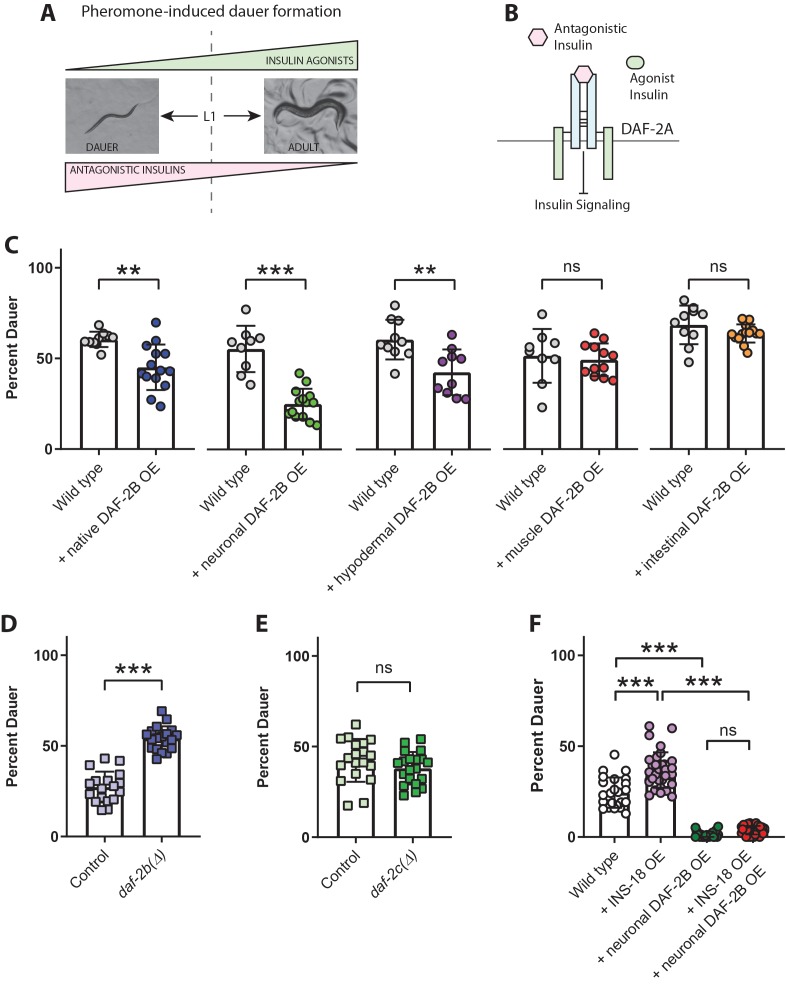
DAF-2B attenuates the activity of antagonistic insulin peptides.(A) In the presence of the dauer-inducing pheromone extracts, the decision in the first larval stage (L1) to proceed with reproductive growth or enter the dauer stage is dependent on the balance between antagonistic and agonistic insulin peptides. (B) Increased activity of antagonistic insulin peptides inhibits insulin signaling to promote dauer entry. (C) DAF-2B overexpression (OE) from the native daf-2 promoter, in the nervous system, or in the hypodermis suppresses pheromone-induced dauer formation in wild type animals. There was no effect of DAF-2B expressed in the intestine or in the body wall muscle. Data are pooled from 2 (hypodermal promoter) or 3 (all other promoters) transgenic lines with at least four biological replicates per transgene. Students t-test ns – not significant, **p<0.01, ***p<0.001. Similar effects were observed in an additional trial for muscle, intestine and neuronal promoters and 1/2 additional trials for the native promoter. Raw data can be found in Figure 7—source data 1. (D) Genetic deletion of daf-2b enhances dauer formation in the presence of pheromone extracts. Data are pooled from two independent trials with three biological replicates from each of two control and two daf-2b(Δ) strains per trial. Students t-test ***p<0.001. Raw data can be found in Figure 7—source data 2. (E) Genetic deletion of daf-2c has no effect on dauer formation in the presence of pheromone extracts. Student t-test ns – not significant. Raw data can be found in Figure 7—source data 3. (F) Overexpression of the INS-18 antagonist insulin peptide from the native ins-18 promoter enhances pheromone-induced dauer formation in wild type animals, while overexpression of DAF-2B from an integrated neuronal rab-3 promoter suppresses dauer formation. Combined overexpression of INS-18 and DAF-2B also suppresses dauer formation compared with INS-18 overexpression alone. Data are pooled from two independent trials with 12 biological replicates for wild type, 11 or 12 biological replicates for the integrated neuronal DAF-2B OE line and 2 or three biological replicates from each of 6 INS-18 OE extrachromosomal array lines. Post-hoc pairwise comparisons following one-way ANOVA ***p<0.0001. Raw data can be found in Figure 7—source data 4. Error bars represent mean ± sd, and data are shown as independent replicates from multiple transgenic lines.Figure 7—source data 1.DAF-2B overexpression suppresses pheromone-induced dauer formation in wild type.Figure 7—source data 2.daf-2bdeletion enhances pheromone-induced dauer formation in wild type.Figure 7—source data 3.daf-2cdeletion has no effect on pheromone-induced dauer formation in wild type.Figure 7—source data 4.DAF-2B overexpression suppresses the effect of INS-18 OE in pheromone-induced dauer formation in wild type.